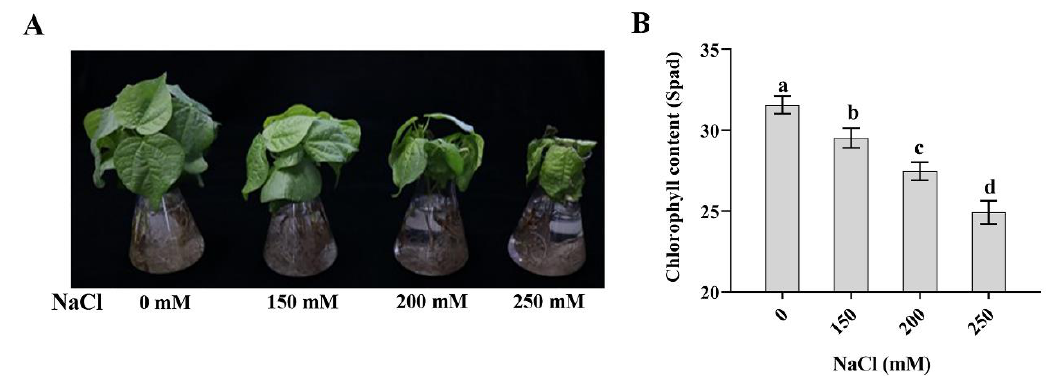
Figure 1. Effects of different NaCl concentrations on growth of cotton seedlings. ( A , B ) Phenotype ( A ) and relative chlorophyll content (Spad) ( B ) of three-week-old cotton seedlings treated with different concentrations of NaCl (0/150/200/250 mM) for 5 days. There were three seedlings per bottle. Values are shown as means ± SD of three biological replicates. Different lowercase letters indicate significant di ff erence ( p < 0.05) between di ff erent groups. Tukey’s test after one-way ANOVA was